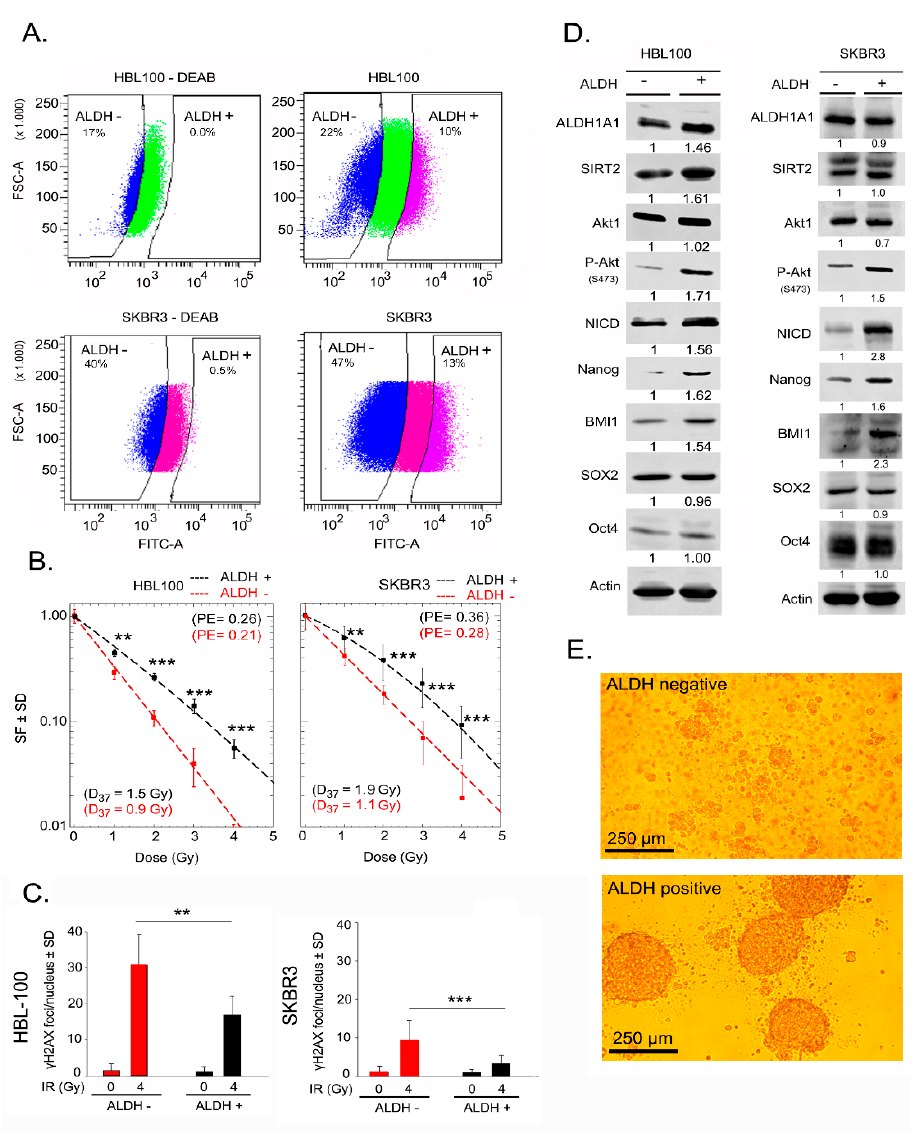
Figure 1. Aldehyde dehydrogenase (ALDH)-positive cells with enriched expression of putative stem cell markers show radioresistance. ( A ) The gating panel of ALDH-positive and ALDH-negative HBL-100 and SKBR3 cells for FACS. Cells were treated with diethylaminobenzaldehyde (DEAB) (40 µ M) as a negative control (left panel), and cells without DEAB treatment were the test group (right panel). The gap between ALDH-positive and ALDH-negative cells was induced by prohibiting mixing of the two populations. ( B ) Clonogenic assays of ALDH-positive and ALDH-negative HBL-100 and SKBR3 sorted cells were performed as described in the Materials and Methods Section. Data points represent the mean surviving fractions (SF) ± the standard deviation (SD) from three independent experiments ( n = 18; ** p < 0.01, and *** p < 0.001, Student’s t-test, PE = plating efficiency). ( C ) In parallel to the colony formation assay, cells were treated with 4 Gy irradiation, and γ -H2AX foci were analyzed 24h after irradiation. Survival curves were prepared based on two independent experiments ( n = 12; ** p < 0.01, and *** p < 0.001, Student’s t-test). ( D ) Protein expression in ALDH-positive and ALDH-negative HBL-100 and SKBR3 cells. Protein samples were isolated after sorting, and the level of the indicated proteins was analyzed using Western blotting. Densitometry values represent the ratio of the intensity of specific protein bands to that of actin bands normalized to 1 in the DEAB nontreated control cells (ALDH -). ( E ) Sphere formation of ALDH positive and negative HBL-100 sorted